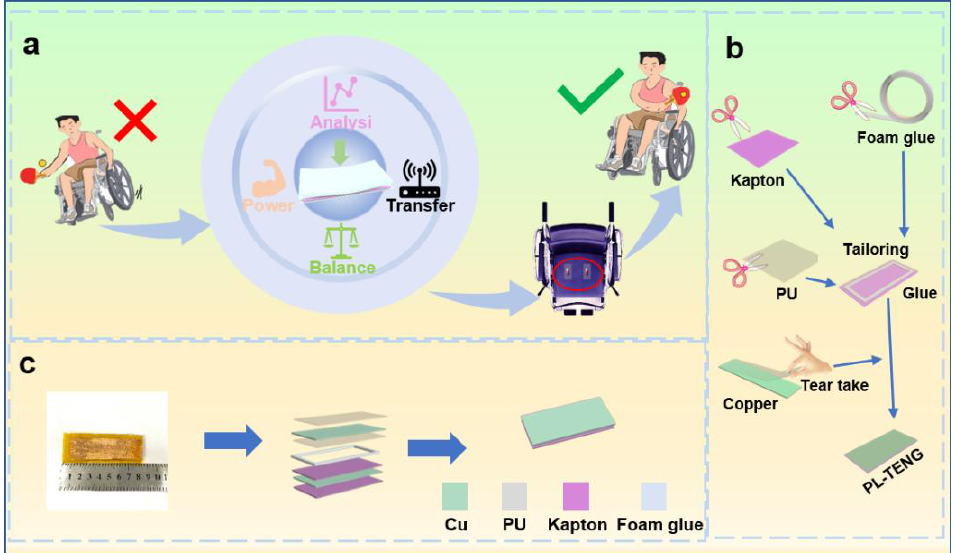
Figure 1. Experimental design for wheelchair table tennis balance monitoring and composition of the PL-TENG. ( a ) Working scenario of the PL-TENG. ( b ) Fabrication process of the PL-TENG. ( c ) Structure and 3D simulation of the PL-TENG.